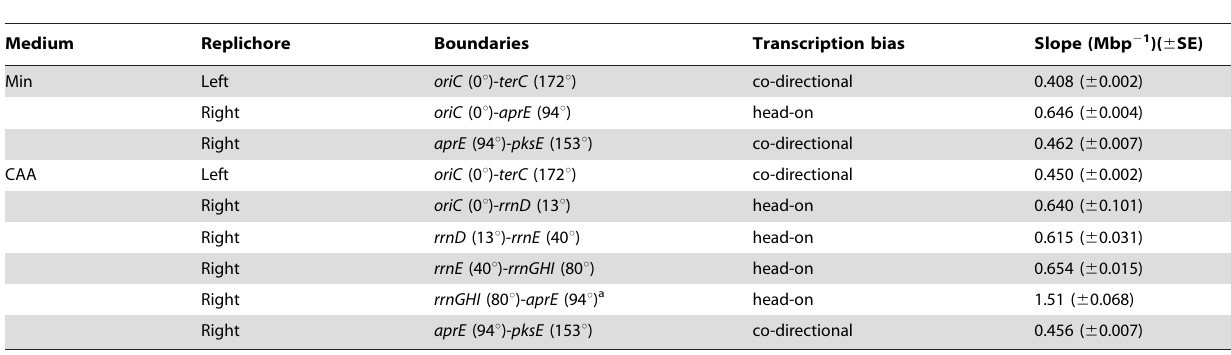
Table 1. Slopes of asynchronous gene dosage profiles in the HT inversion strain.